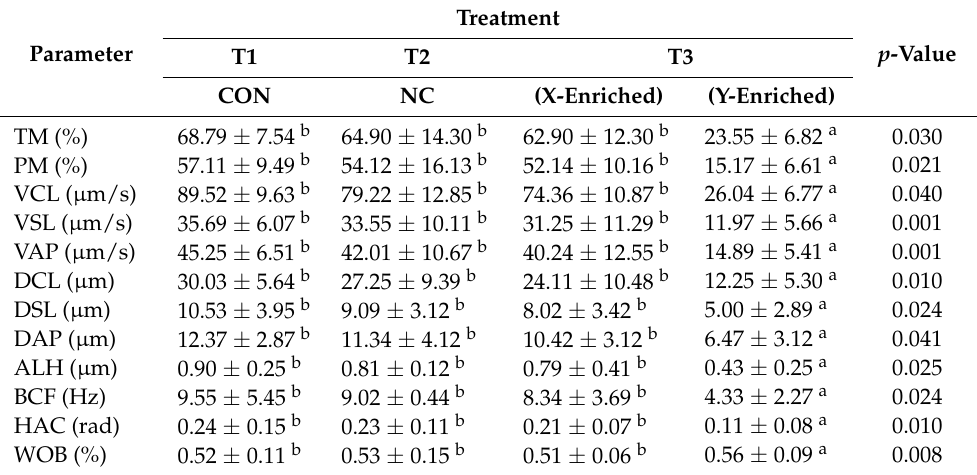
Table 3. Evaluation of motility and kinematics of frozen–thawed sexed semen by PY-microbeads ( n = 20; mean ±